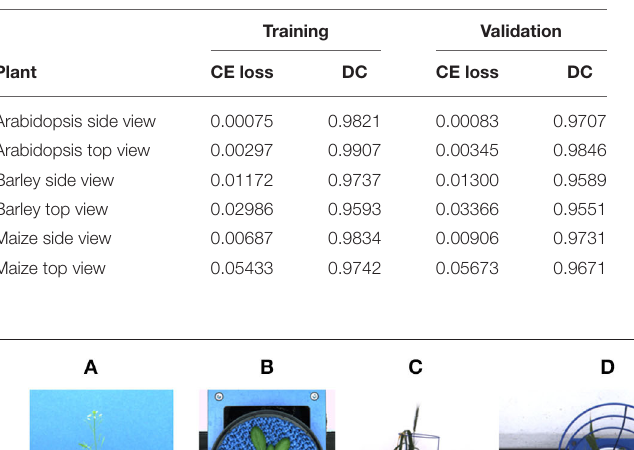
TABLE 4 | Training and validation performance of the shoot models.